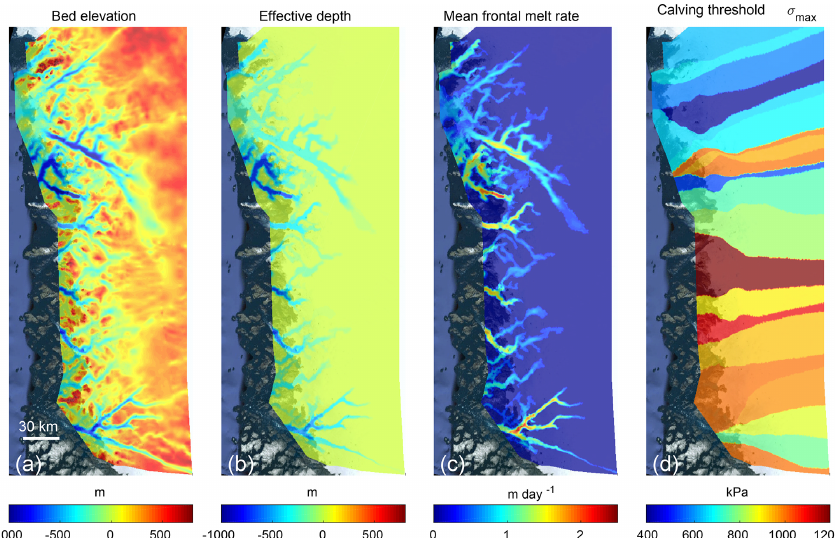
Figure 3. (a) Bed topography (m), (b) effective depth (m), (c) calculated mean rate of undercutting from 2007 to 2017 (mday − 1 ), and (d) calibrated σ max